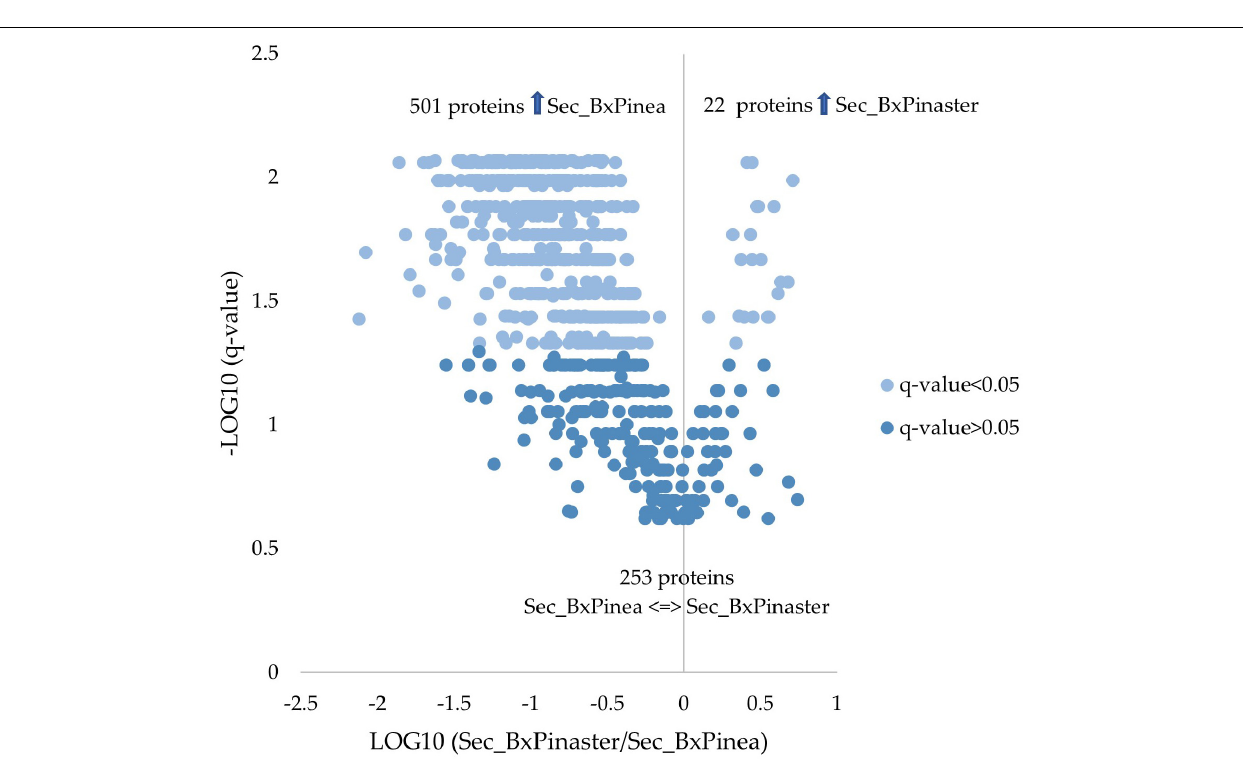
FIGURE 2 | Quantitative proteomic analysis. Volcano plot with the results from the statistical analysis of the 776 proteins quantified among the secretomes of Bursaphelenchus xylophilus under Pinus pinaster (Sec_BxPinaster) and P. pinea (Sec_BxPinea) stimuli. Statistical analysis was performed by the Mann–Whitney U test, and statistical significance was considered for q values <